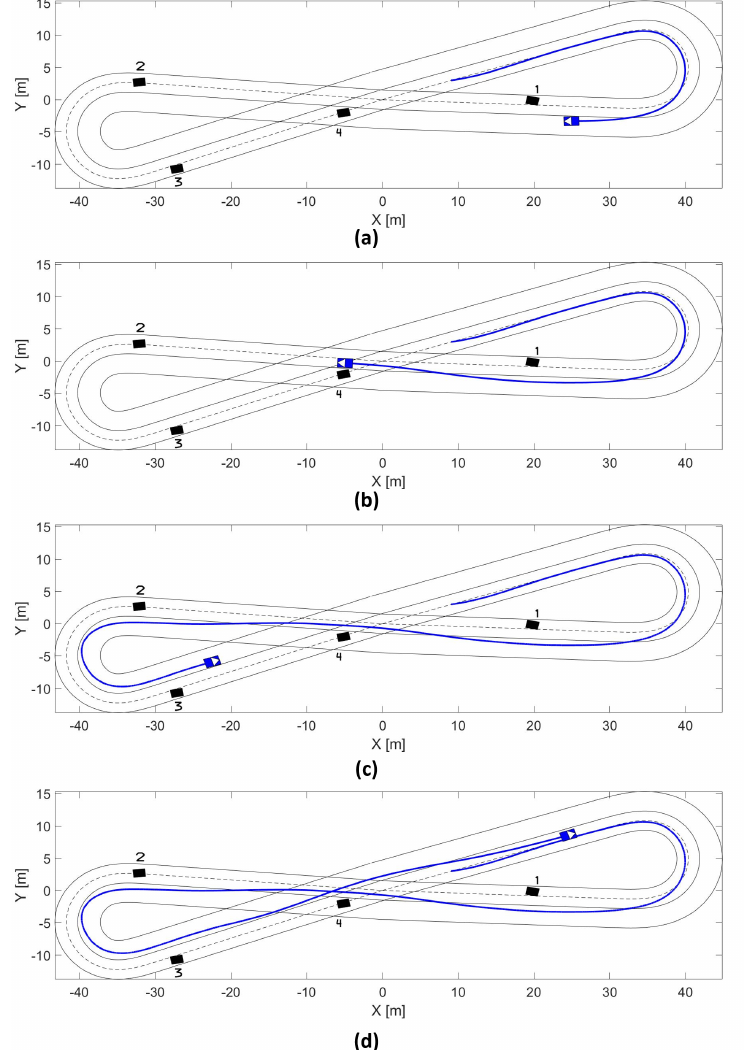
Figure 8. ( a ) Low-medium speed test track until 17 s, ( b ) low-medium speed test track until 22.5 s,